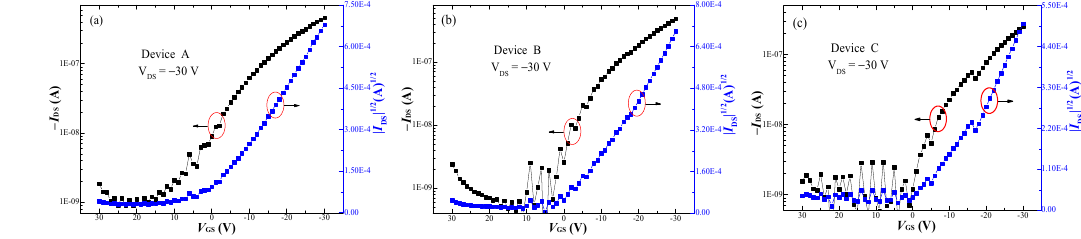
Figure 4. ( a )–( c ) The initial transfer characteristics of devices A, B, and C. Figure 4. ( a – c ) The initial transfer characteristics of devices A, B, and